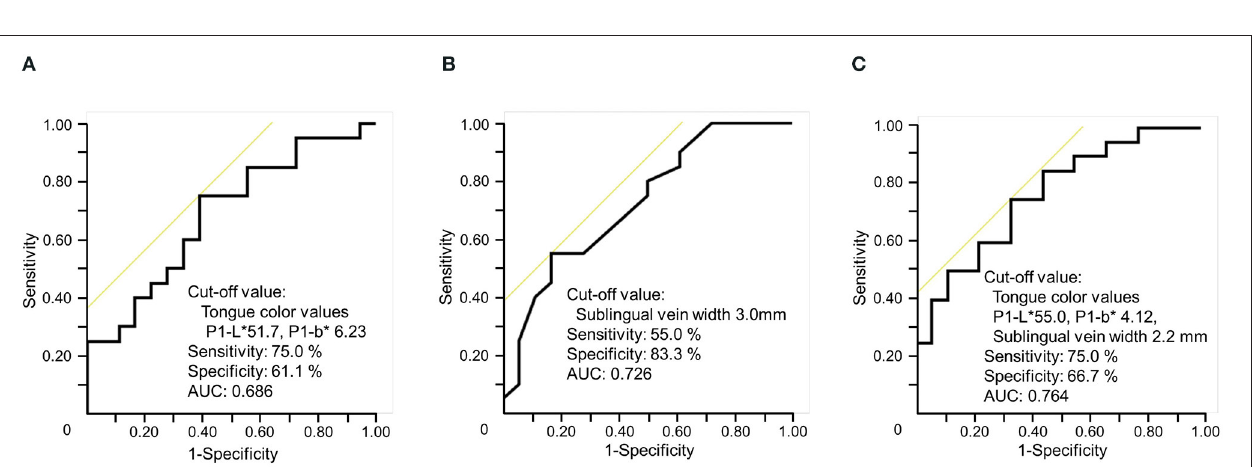
FIGURE 2 | (A) Tongue Image Analyzing System: TIAS. (B) Tongue images of two clinical cases. Top: The tongue color values. Bottom: The sublingual vein width. Case 1. Blood stasis score 20, Case 2. Blood stasis score 39. P1 (tongue edge), P4 (tongue apex). L* for lightness (brightness to darkness), a* for chromaticity (redness [ + a] to greenness [–a]), and b* chromaticity (yellowness [ + b] to blueness [–b]).